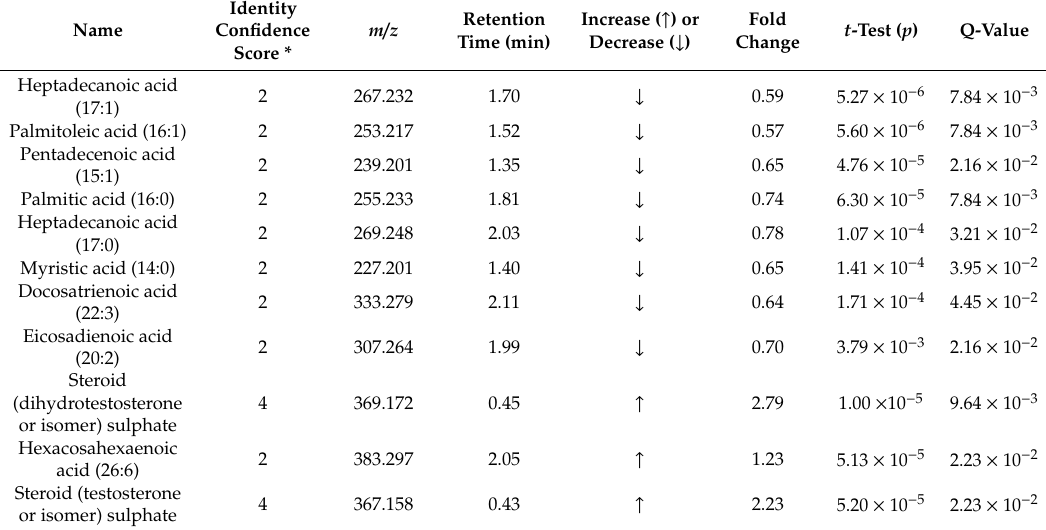
Table 2. Significantly changed lipid compounds that decreased or increased between PCOS and control (plasma samples). Discovery determined using the two-stage linear step-up procedure of Benjamini, Krieger and Yekutieli, with Q = 5%. Each row was analysed individually, without assuming a consistent SD. * Metabolite identification confidence score as described elsewhere [12].